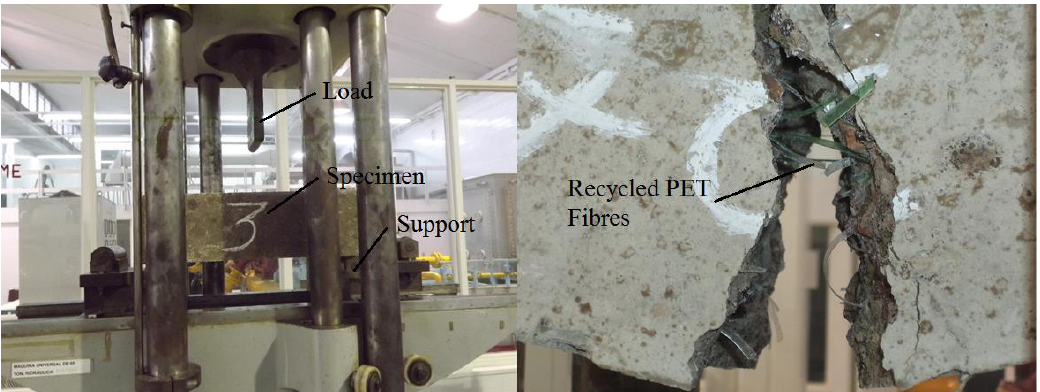
Materials 2021 , 14 , x FOR PEER REVIEW